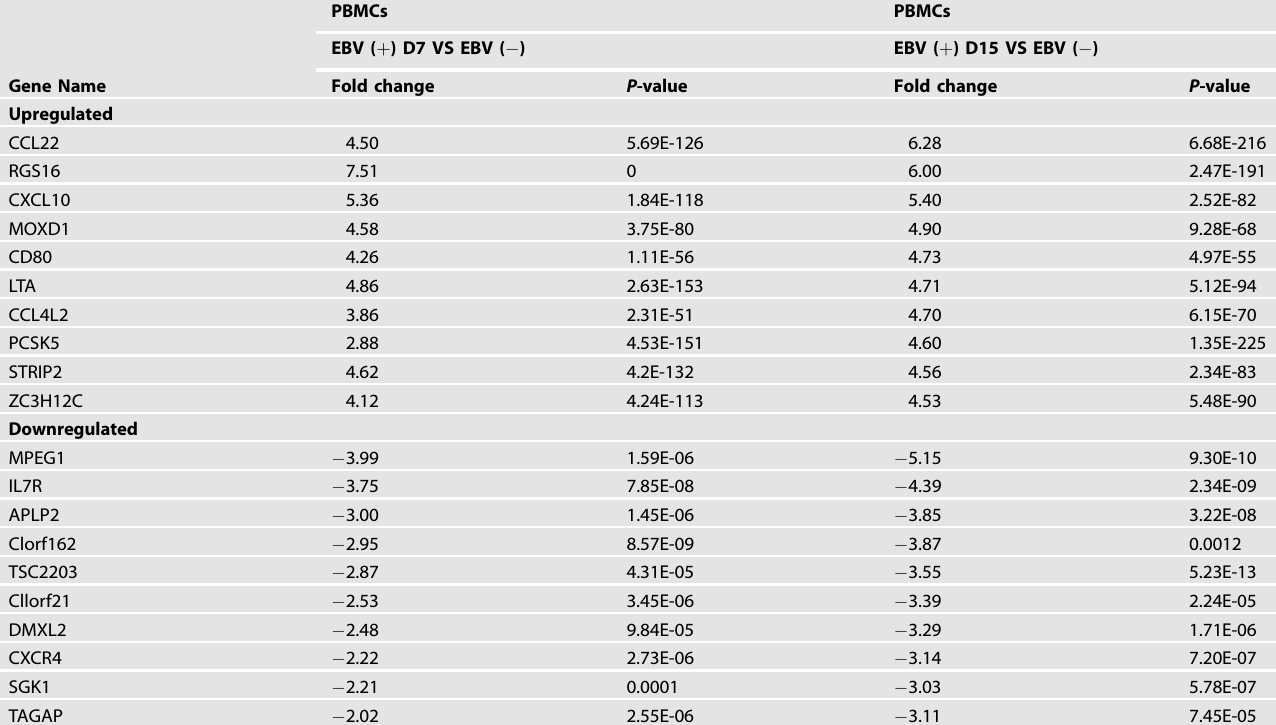
Table 4. Most signi fi cant differentially transcribed RNAs in PBMCs after 7 and 15 EBV